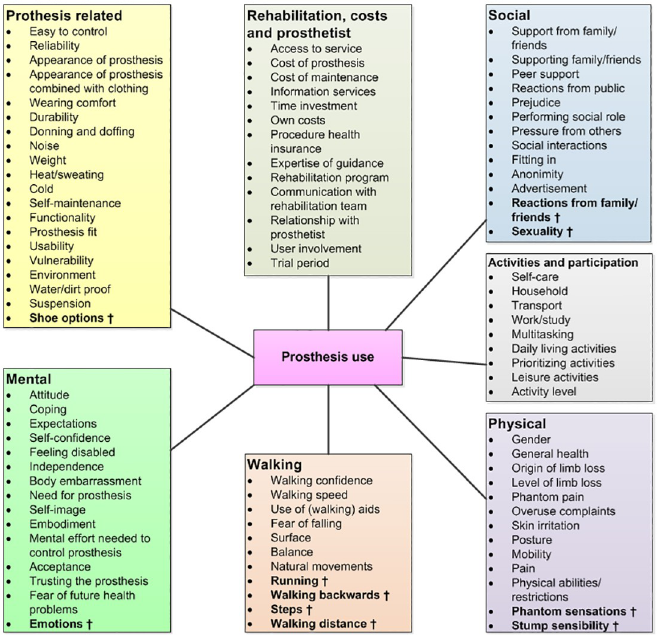
Fig 2. Overview of the themes and factors of the final framework †added during focus